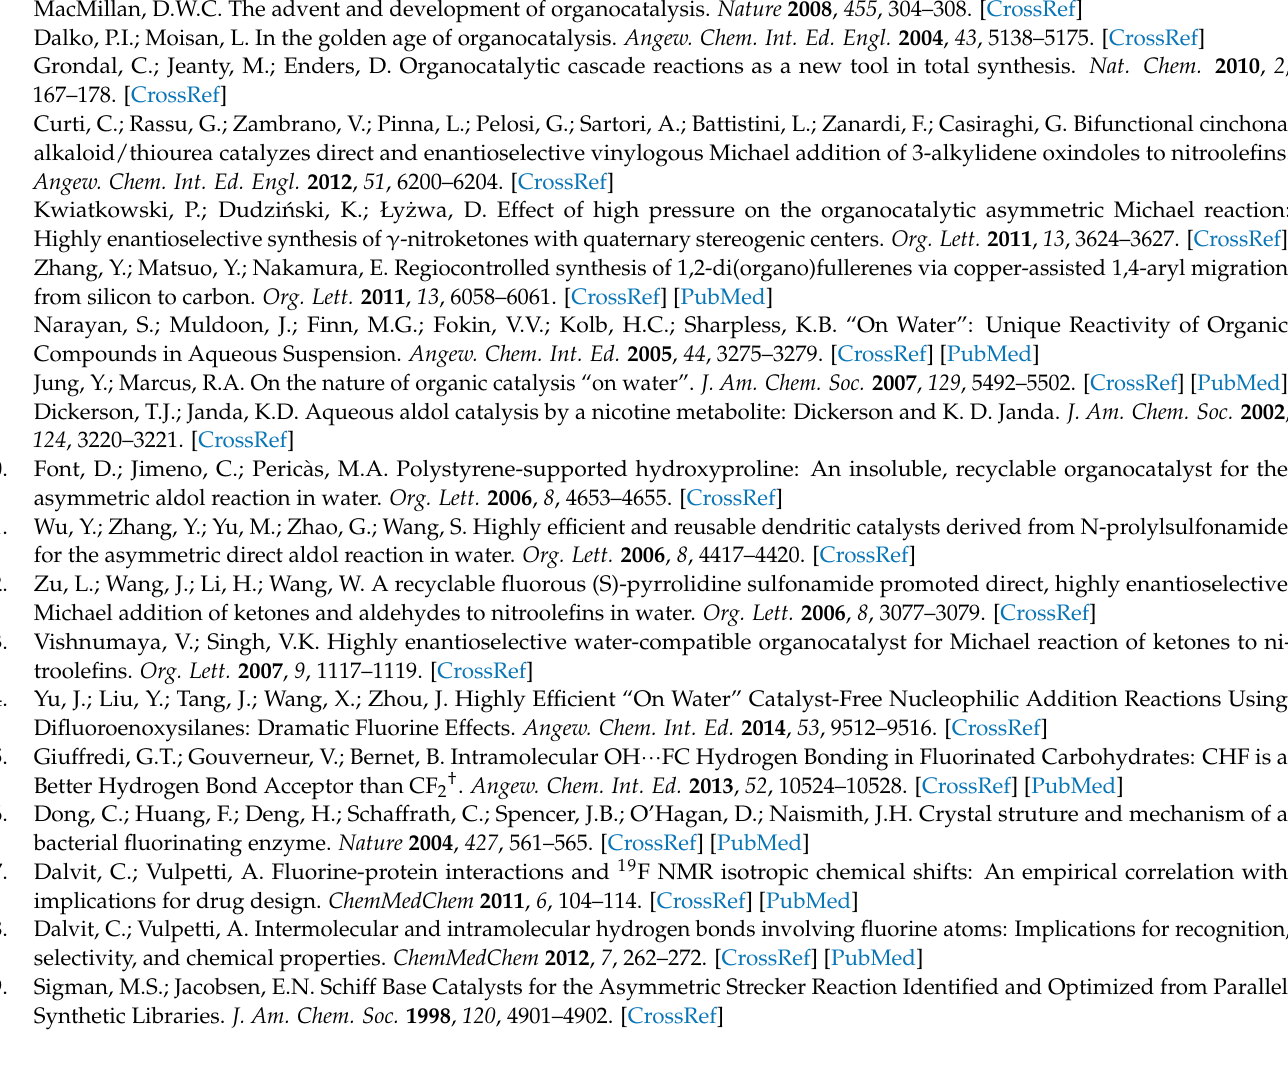
Table S3. Substrate effects of malonate. Table S4. Catalyst effects on the Michael